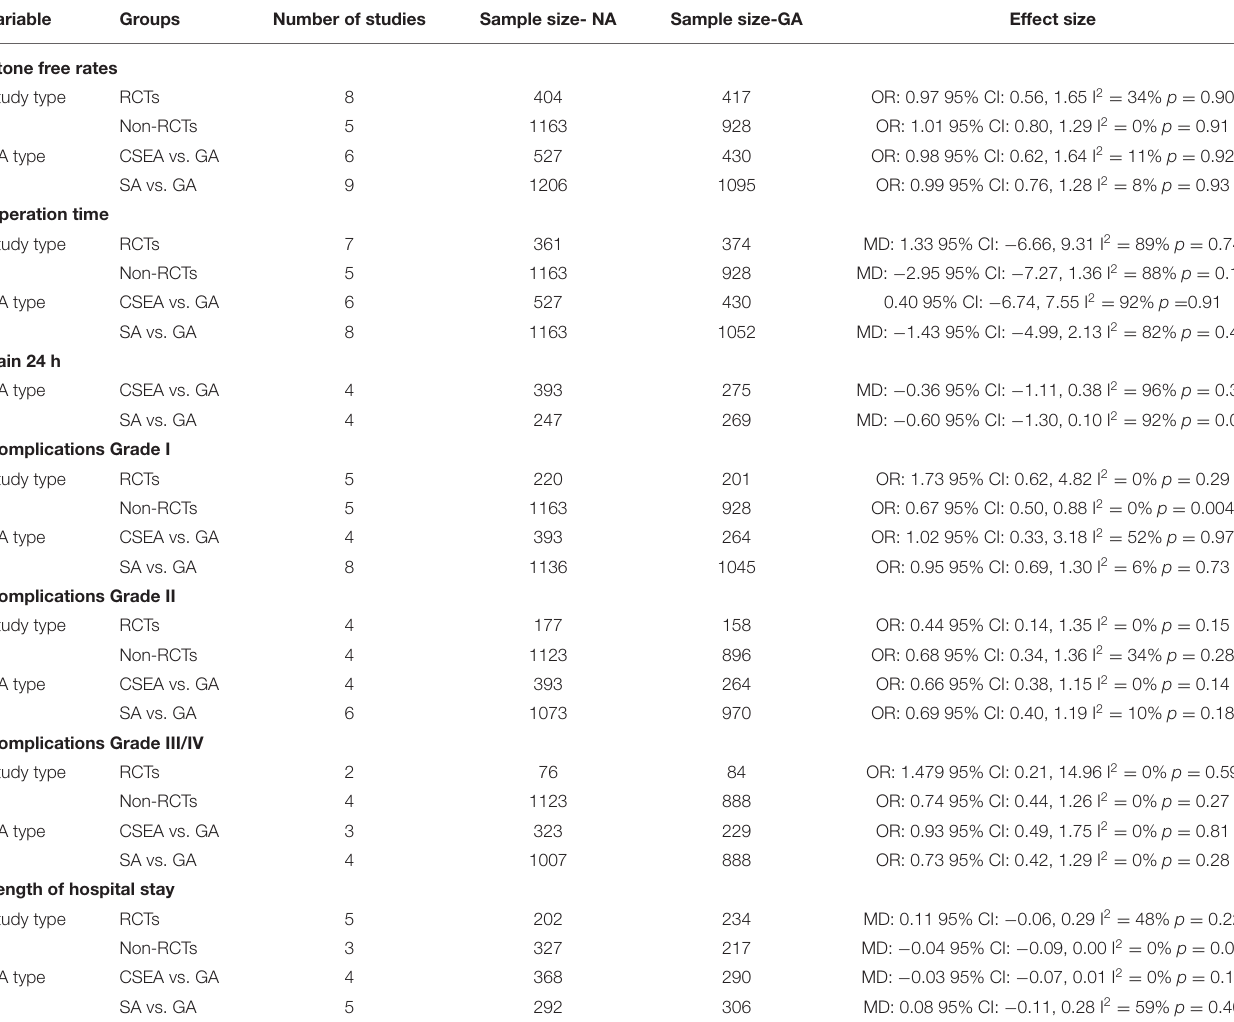
TABLE 2 | Details of subgroup analysis.